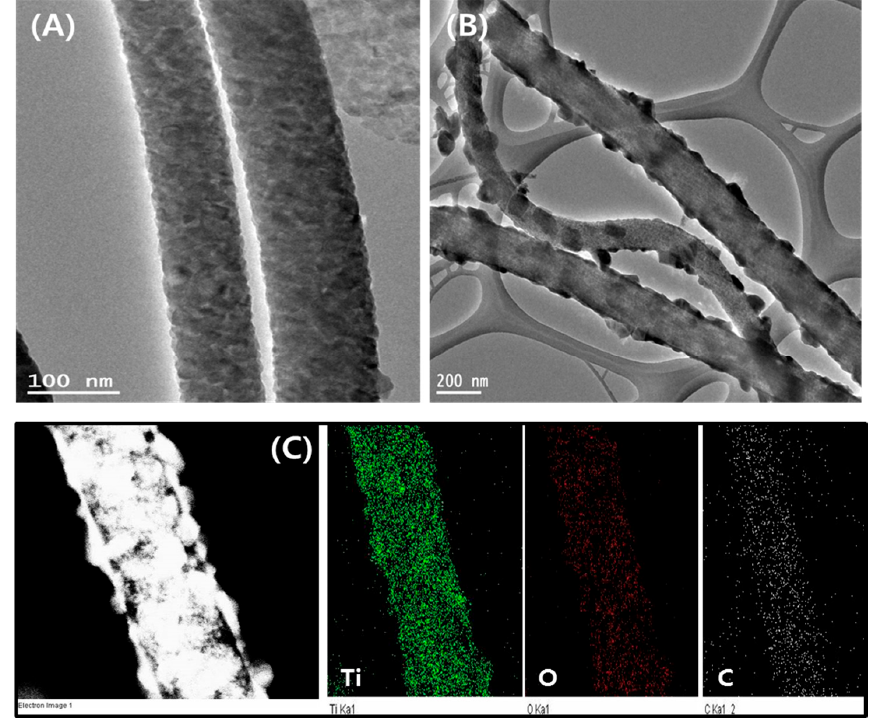
Figure 5. Transmission electron microscopy (TEM) images of pristine TiO 2 NFs ( A ) and TiO 2 -CNFs ( B ). ( C ) shows the elemental mapping of the TiO 2 -carbon NF samples.